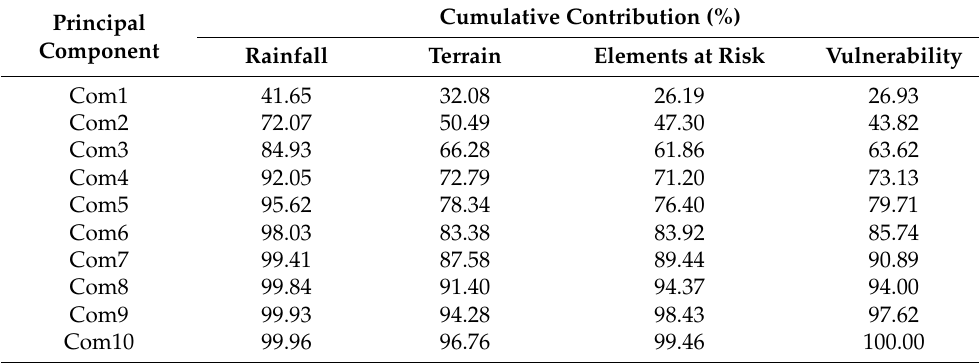
Table 5. Cumulative Contribution of Principal Components.